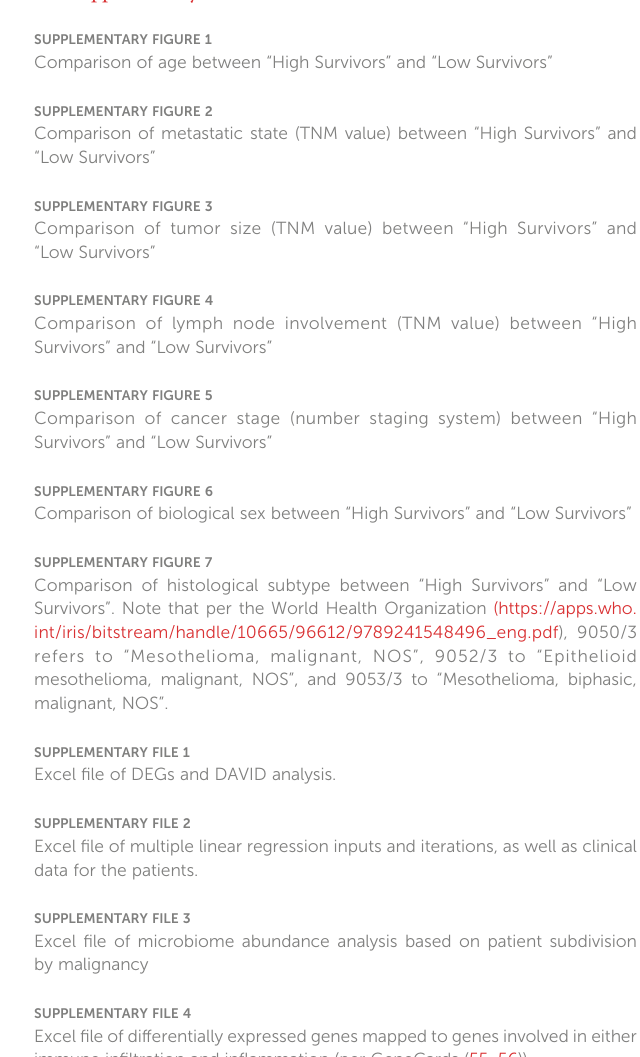
SUPPLEMENTARY FIGURE 1 Comparison of age between “ High Survivors ” and “ Low Survivors ”